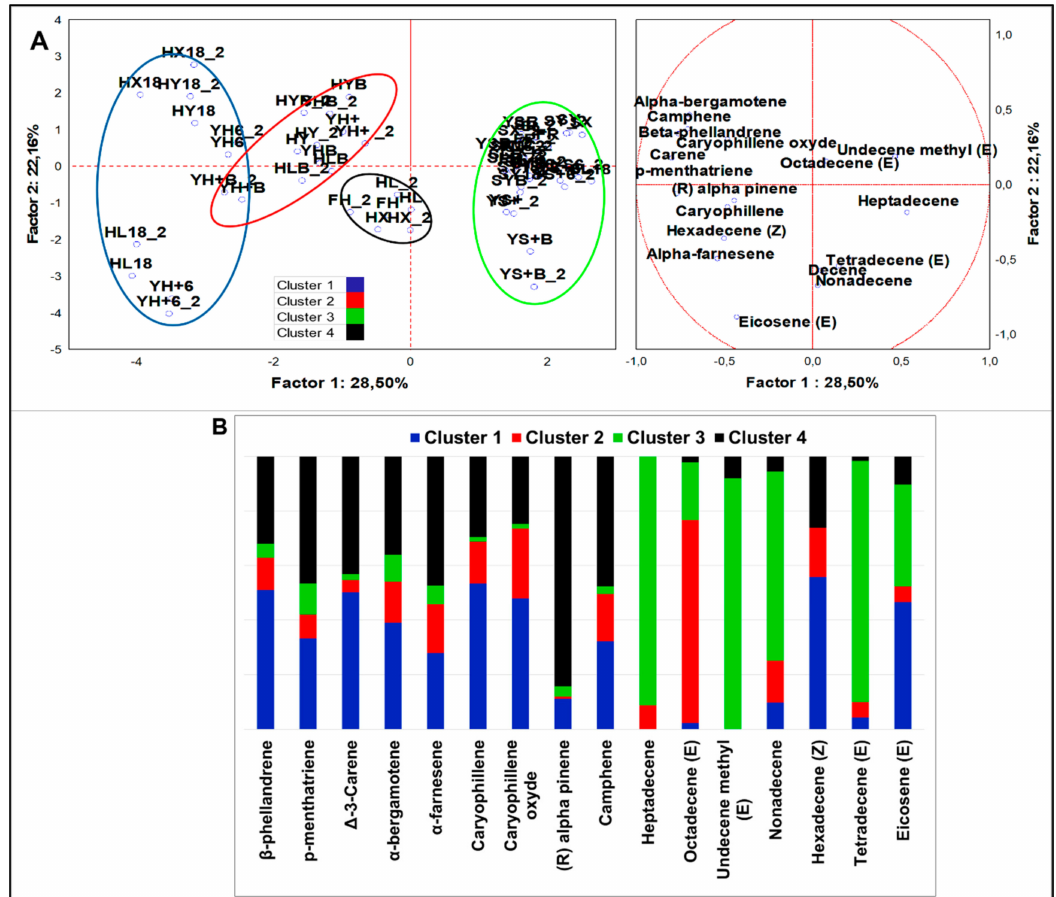
Figure 5. ( A ) PCA of cases and variables on alkenes ( p < 0.05); ( B ) K-means clustering analysis (at least p <